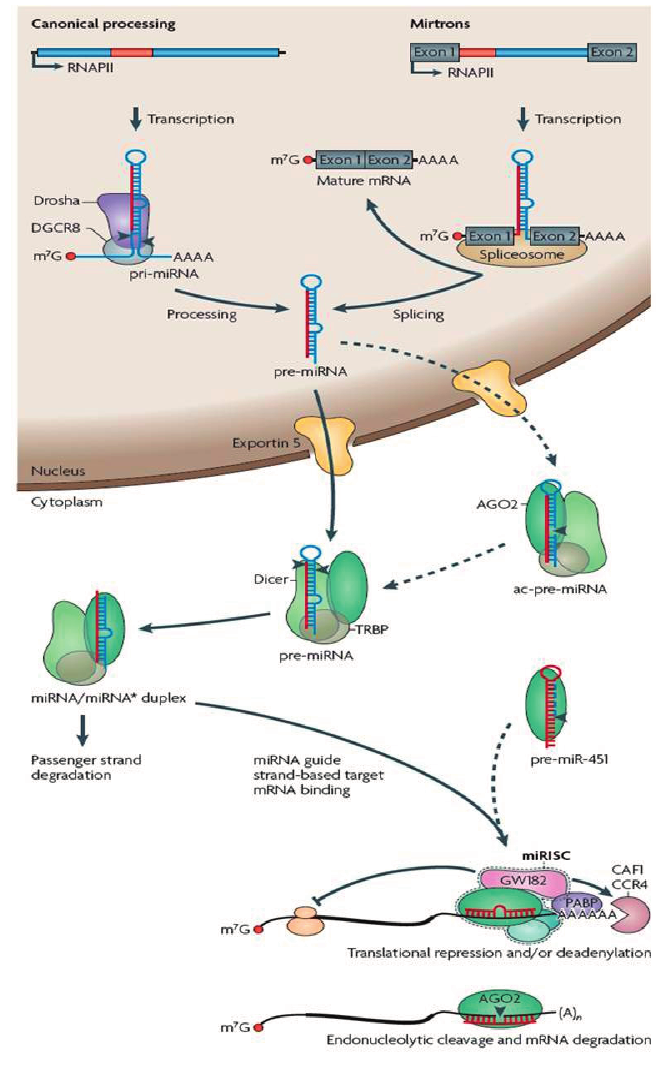
Figure 1. miRNA biogenesis. miRNAs are transcribed as long primary miRNAs (pri-miRNAs) in the nucleus by the canonical processing or from mirtrons. In the canonical processing pathway, pri-miRNAs are cleaved into 60–70 nt precursor miRNAs by the RNaseIII endonuclease DROSHA and transported to the cytoplasm by RAN-GTP dependent exportin-5, or in the mirtron pathways, pre-miRNAs result from debranching and splicing of pre-mirtons. In the cytoplasm, the pre-miRNA is cleaved by DICER into a short miRNA/miRNA* duplex and the mature miRNA can then be loaded into the miRISC and exert its function on its target mRNA, by target degradation or repression (Adapted from Krol et al. 2010)